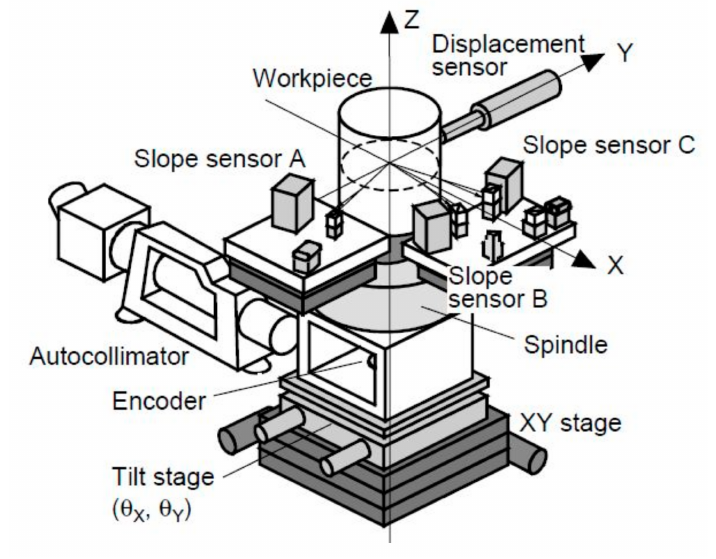
Figure 23. Test stand with biaxial slope sensors [27].